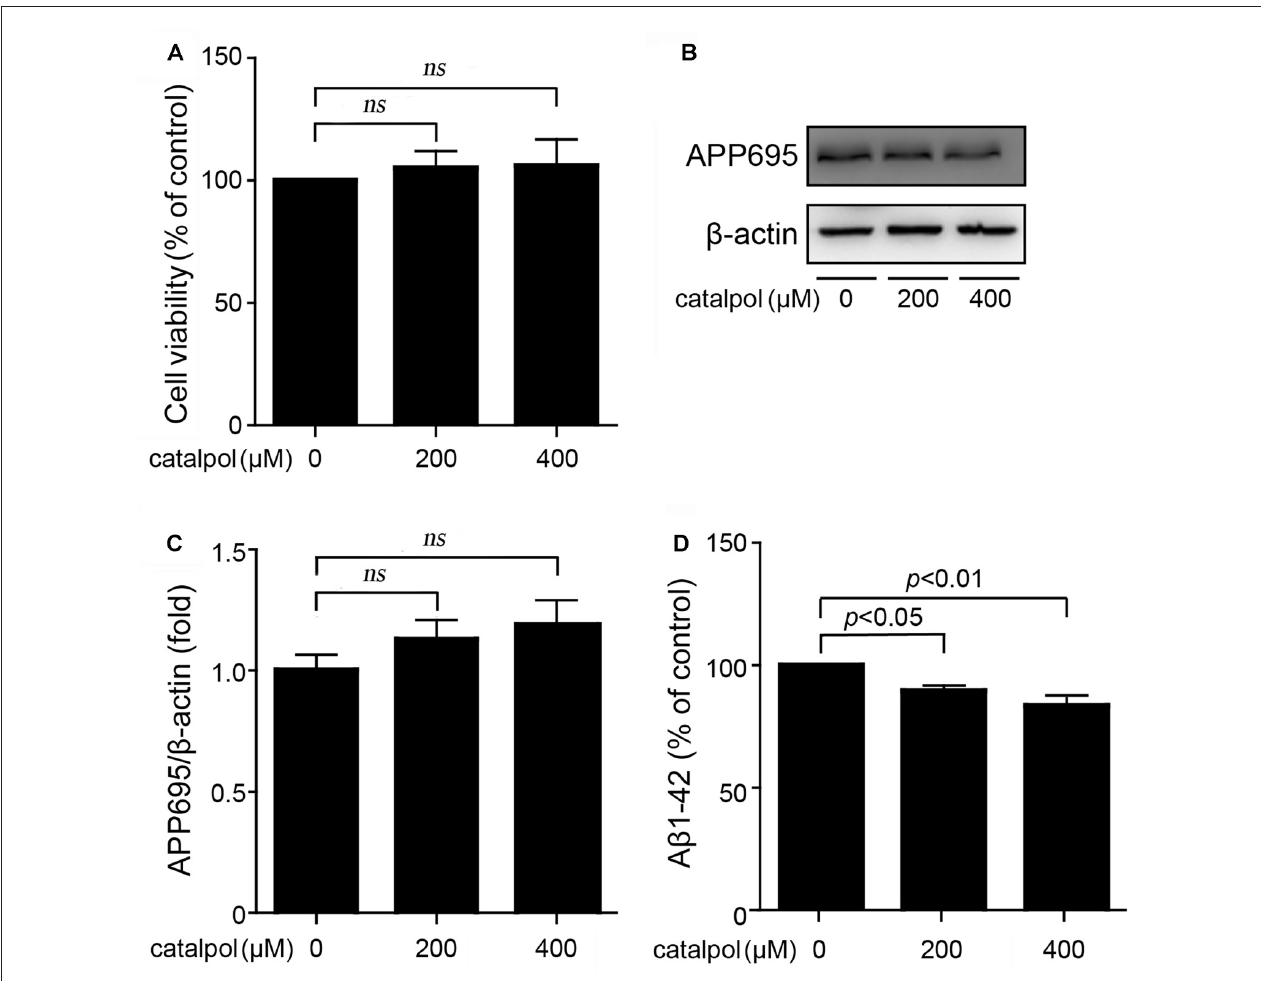
FIGURE 1 | Catalpol inhibited Amyloid- β (A β ) generation and secretion in Swedish mutant APP overexpressed N2a (SweAPP N2a) cells. (A) SweAPP N2a cells were treated with catalpol for 18 h, at the concentrations of 200 and 400 µ M, respectively. Cell viability was detected by MTT assay. The results showed that catalpol has no significant effect on cell viability. (B) Immunoblot images and (C) quantifications showed that catalpol did not affect the expression levels of APP695. (D) ELISA analysis showing that catalpol was able to decrease A β 1–42 levels in the conditional culture medium after treatment for 18 h. The data are expressed as the mean ± standard error of the mean (SEM). n = 3. The p values were calculated using one-way